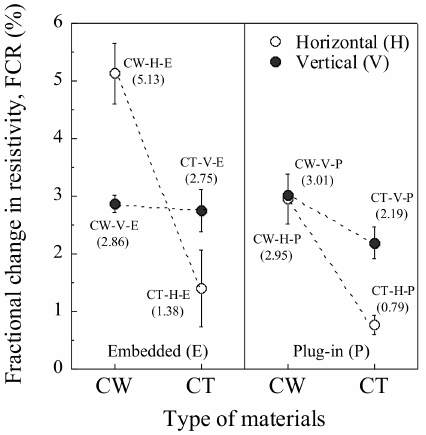
Figure 13. Effects of electrodes materials under compressive stress of 60 MPa.